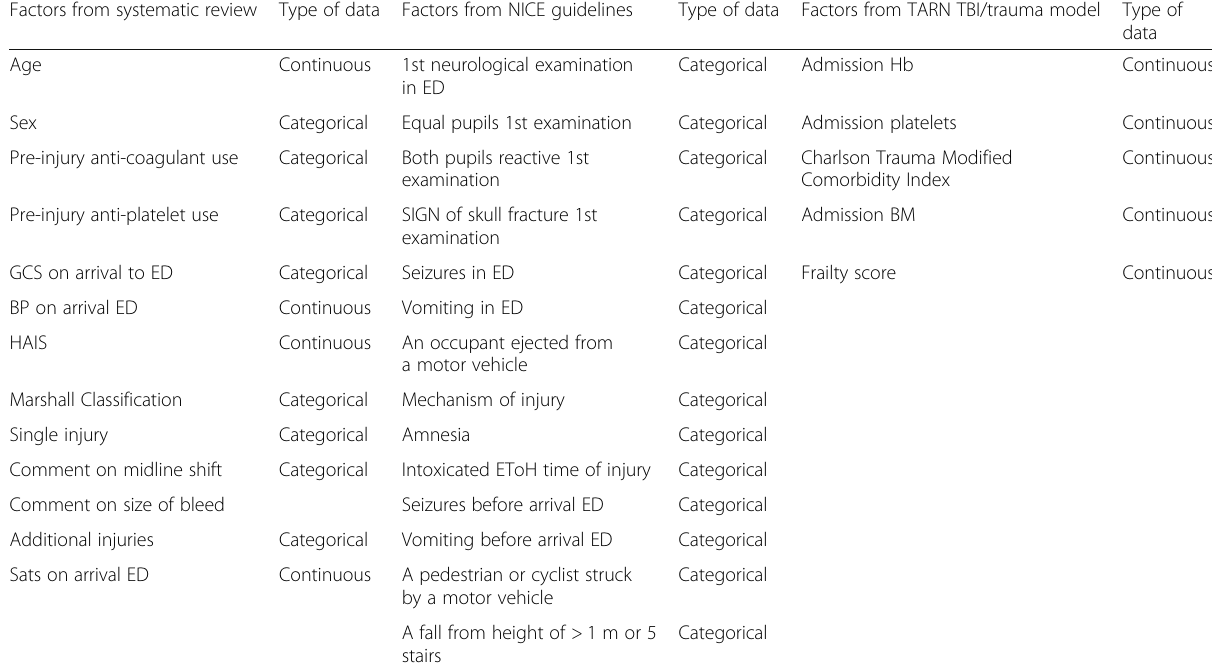
Table 1 Prognostic factors being investigated Factors from systematic review Type of data Factors from NICE guidelines